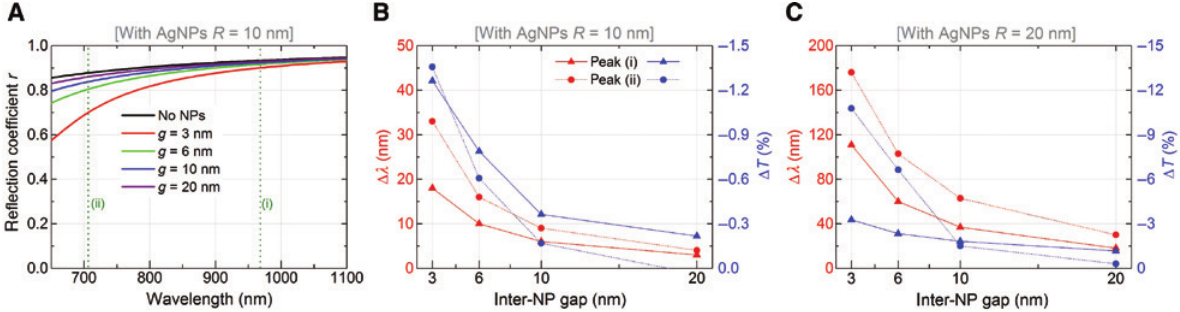
Figure 6: Influence of inter-NP gap on cavity mirror’s reflectance and resulting shift in the cavity’s transmittance peaks. (A) Reflection coefficient ( r ) of each cavity mirror, where Ag NPs of radius R = 10 nm are assembled to form monolayers of different density (cf. indicated inter-NP gaps) on a 20-nm-thick Ag film immersed in an aqueous electrolyte. (B) The shift in peak wavelength, ∆ λ , (in red) along with changes in transmittance percentage, ∆ T , (in blue) as a function of inter-NP gaps for peaks (i) and (ii) (the peaks are those shown in Figure 4A). (C) Same as in (B) but for Ag NPs of radius R = 20 nm.